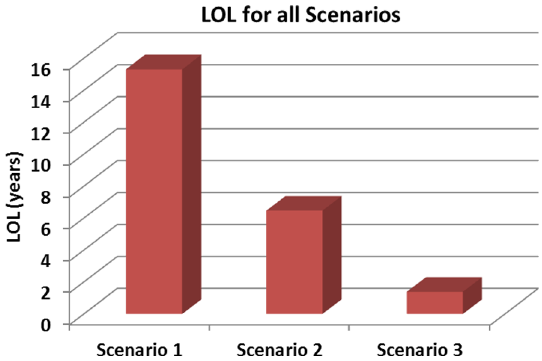
Fig. 4. LOL for different scenarios over 5-year